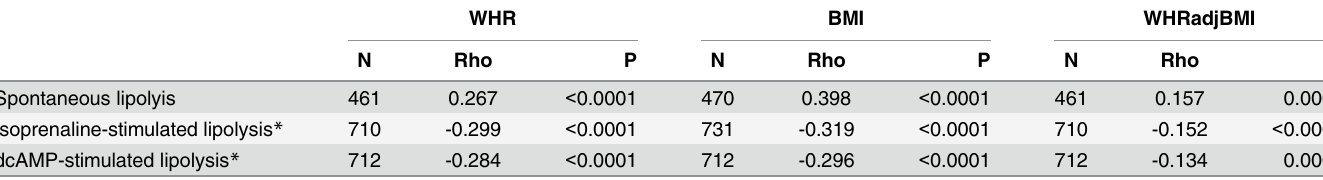
Table 3. Spearman rank correlations of obesity phenotypes with adipocyte lipolysis